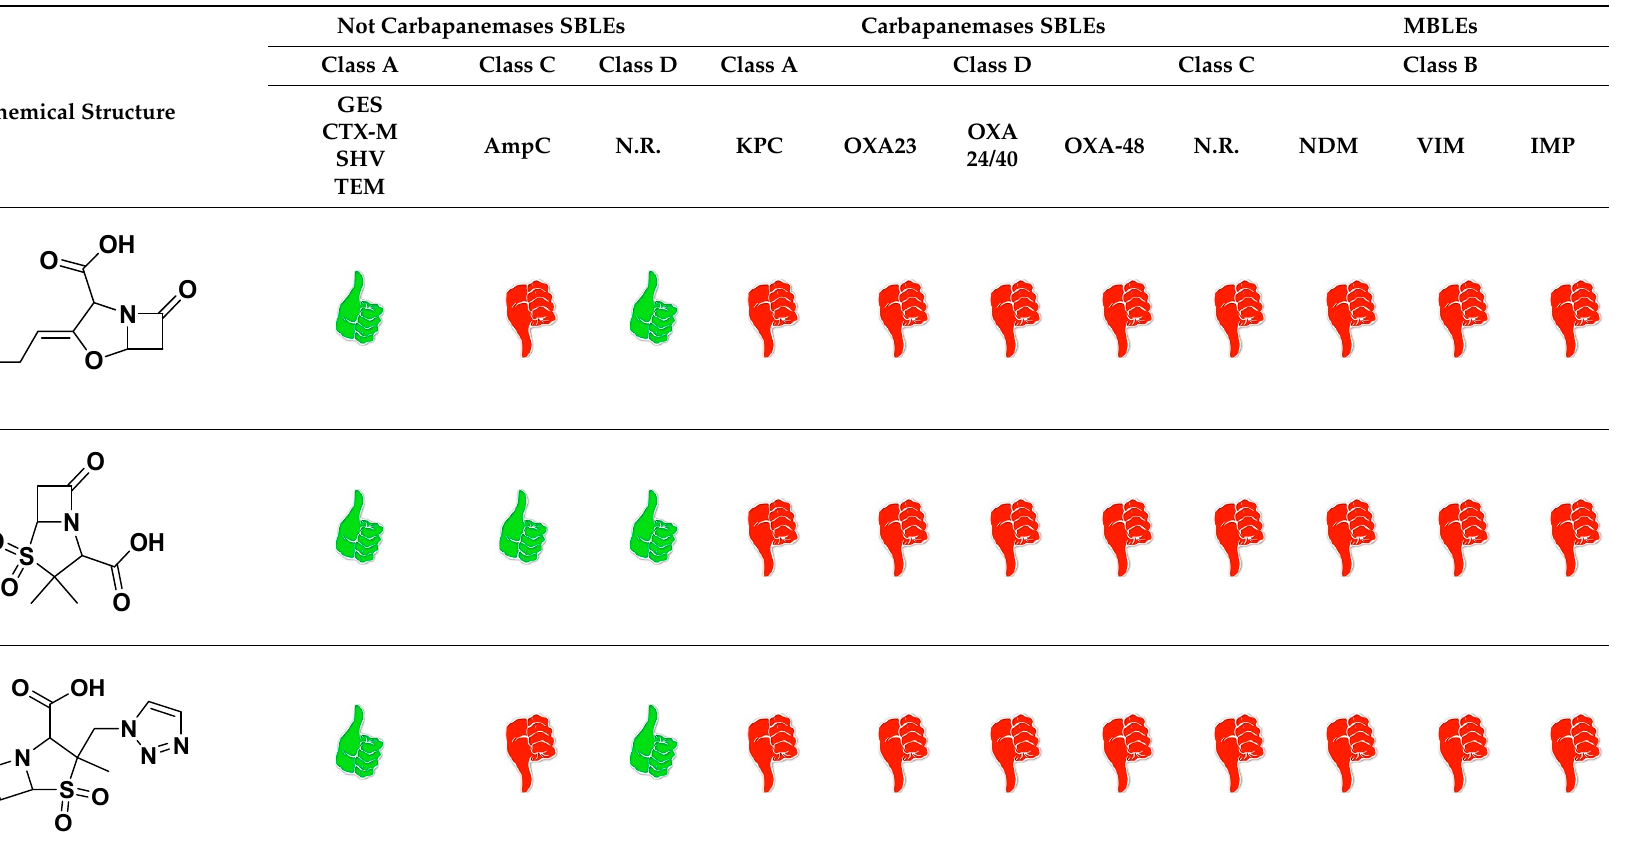
Table 3. Long-standing or recently approved BLEsIs, molecules still at preclinical and clinical trials, and molecules still at the early stages of experimentation. BLEsIs